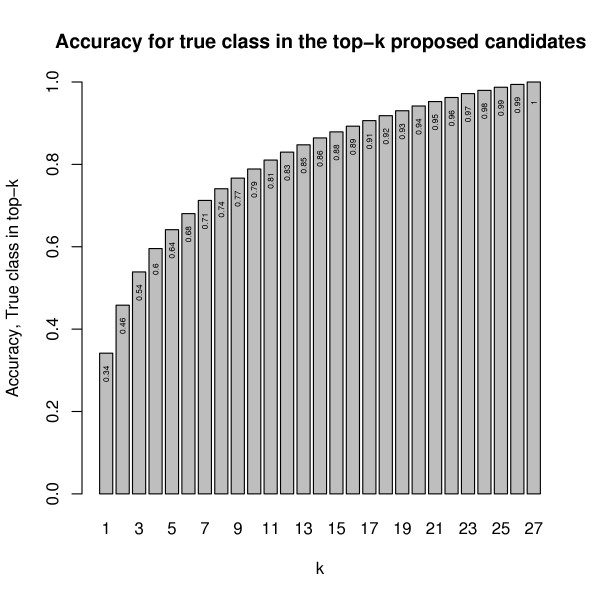
Correct classifications, if the top-k ranked predictions are used (20,000 samples, RF classifier).